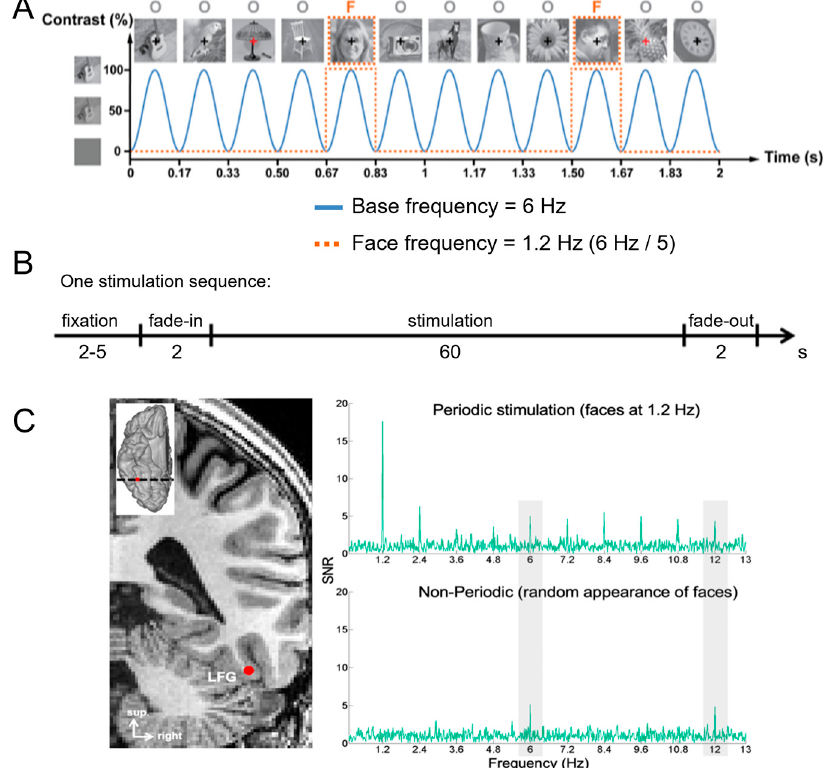
Figure 2. ( A ) Experimental FPVS paradigm as used in our laboratory since December 2012 to record face-selective intracerebral activity in human subjects. Images of objects are presented by sinusoidal contrast modulation at a rate of six stimuli per second (6 Hz, depicted as a blue sine wave), with a different face image presented every five stimuli (i.e., appearing at the frequency of 6 Hz/5 = 1.2 Hz; show in orange boxes; see [54] for paradigm details). O: objects, F: faces. Typically, the neural responses are recorded implicitly, in the sense that participants are not asked to recognize faces (usually they are instructed to fixate a cross appearing over the images and detect random